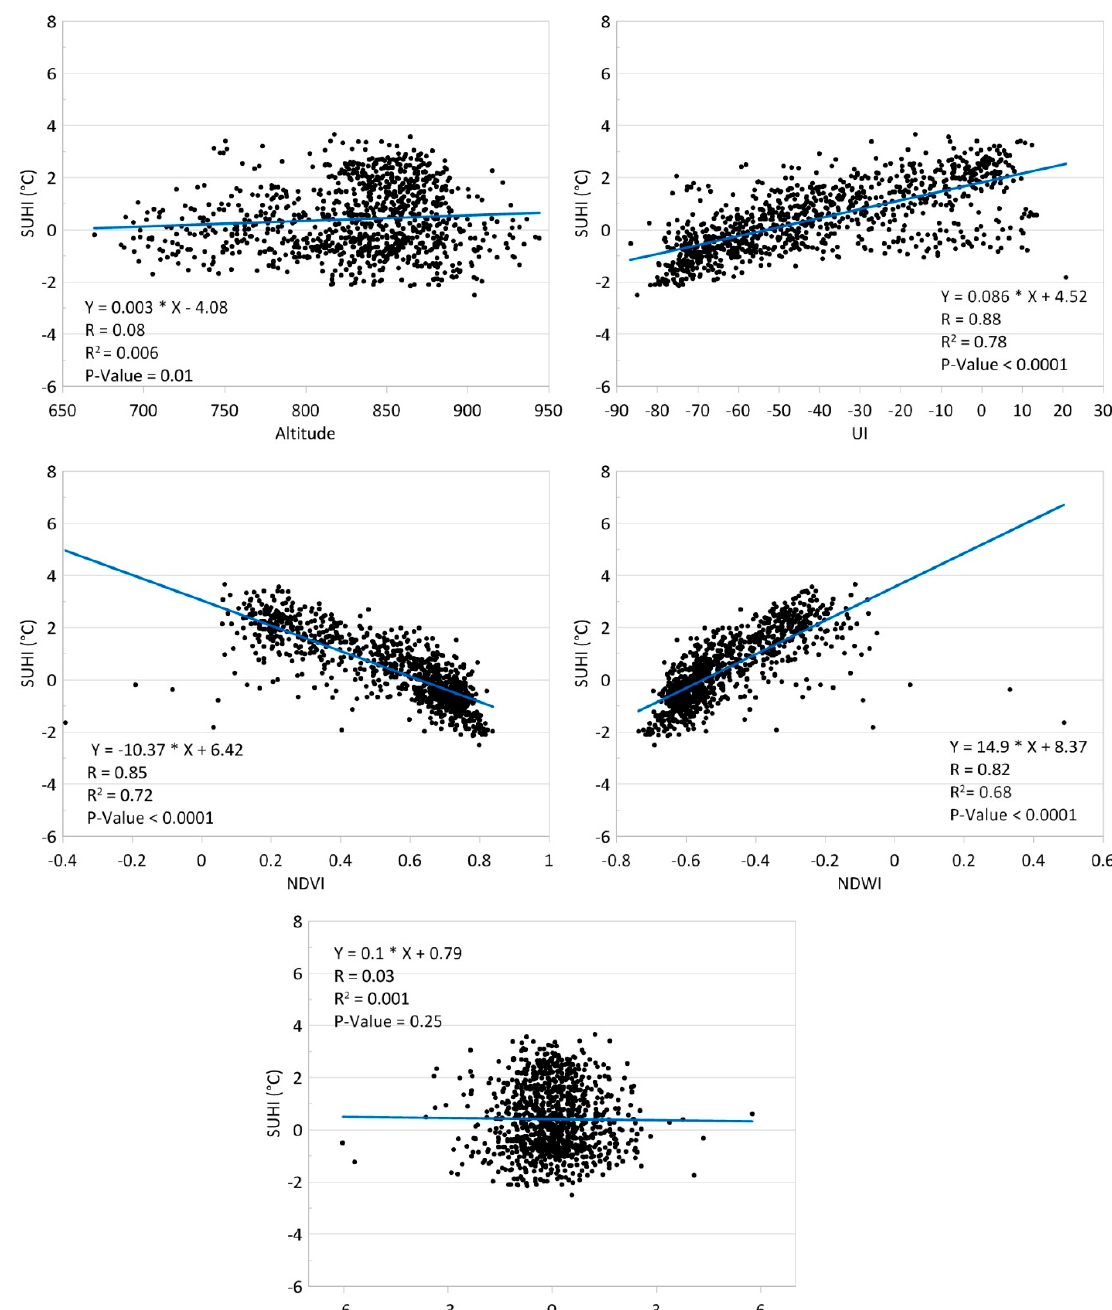
Figure 8. SUHI versus Altitude, UI, NDVI, NDWI and TPI scatter plots in the summer.